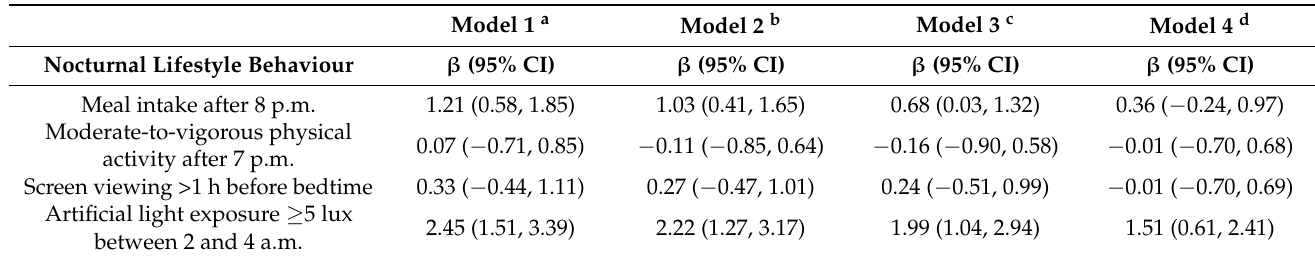
1: crude model. b Model 2: nocturnal lifestyle behaviours were mutually adjusted in a single regression model. c Model 3: Model 2 + maternal age, ethnicity, education, employment status, working overtime, and pre-pregnancy body mass index. d Model 4: Model 3 + negative emotion. Table 3. The associations between nocturnal lifestyle behaviours and global Pittsburgh Sleep Quality Index score among pregnant women ( n = 299).